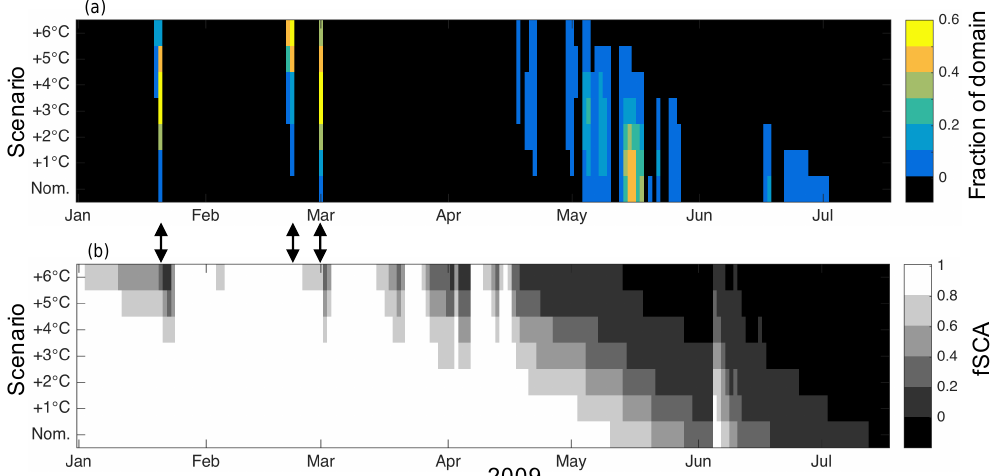
Figure 10. Daily extreme snowmelt in 2009 (melt rates >40mmday − 1 at model grid cells >2250ma.s.l., corresponding to extreme melt rates, ≥ 99th percentile; see Fig. 8) as simulated by the nominal (Nom.) and six perturbed temperature scenarios ( y axes) shown as the (a) fraction of the area undergoing extreme melt. The lower panel shows the fraction of snow-covered area (fSCA) for the same time period and domain. Arrows indicate (winter) melt events (see Table 3 for meteorological conditions and averages).